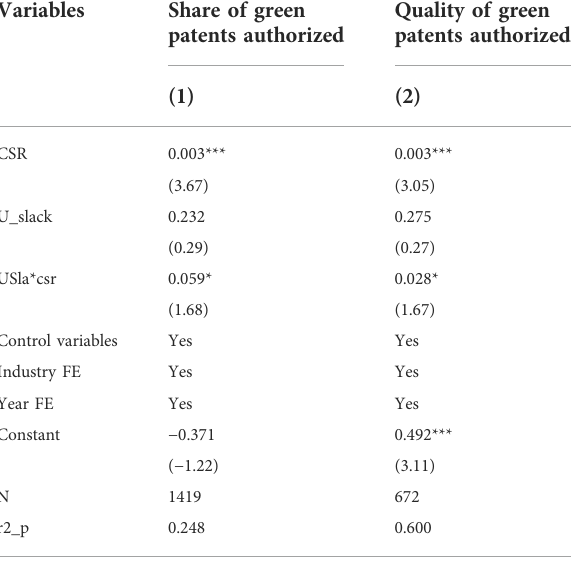
TABLE 8 Changing the measurement of the dependent